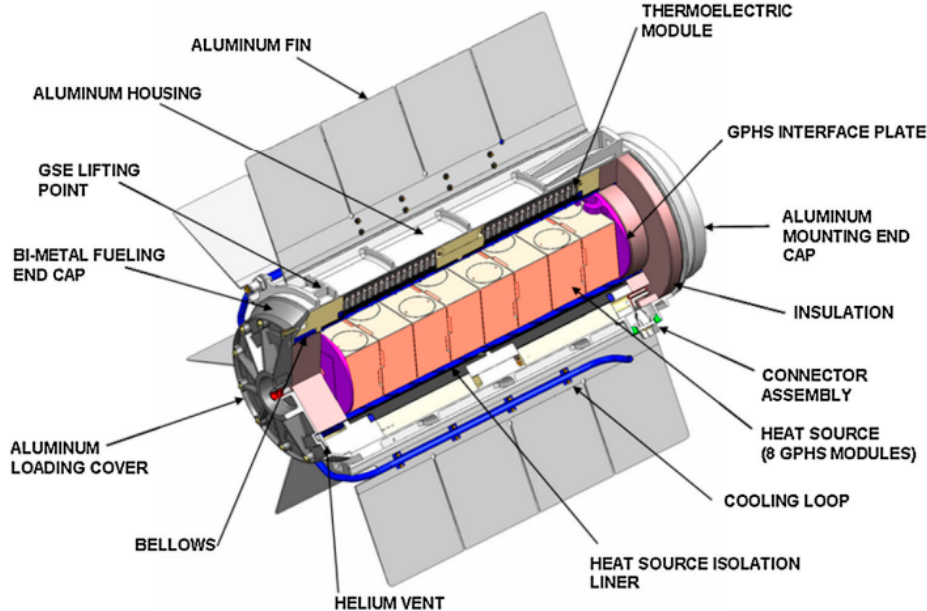
Figure 5. Cutting view of an Multi-Mission Radioisotope Thermoelectric Generator MMRTG [103].